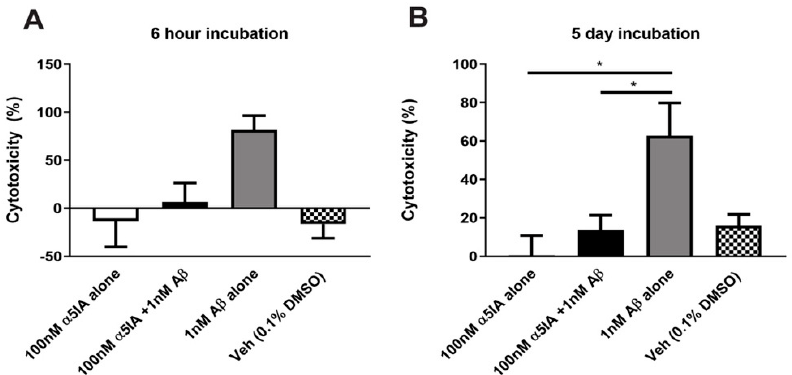
Figure 2. Cytotoxicity (%), measured by LDH release, in mouse primary hippocampal cultures following treatment with 100 nM α 5IA and 1 nM A β 1-42 for 6 h ( A ) and 5 days ( B ). Cells lysed with 1% Triton X-100 in maintenance media were used as the positive control. Values were expressed as a percentage of the positive control and normalized to untreated controls. Data is expressed as mean ± SEM. * p < 0.05, One-way ANOVA with Bonferroni’s post hoc test, ( n = 5–8). To further evaluate cell viability, primary cultures were co-stained with NeuN and the apoptotic marker cleaved-caspase 3 (CC3), following treatment with A β 1-42 alone, α 5IA alone or A β 1–42 with α 5IA, to detect and quantify the number of apoptotic neuronal cells. Treatment with a combination of 100 nM α 5IA and 1 nM A β 1-42 resulted in a significant decrease in apoptotic cell death compared with A β 1-42 -treated cultures (Figure 3C; p = 0.01, n = 12). This indicates trends similar to those observed in the previous cell viability assays.